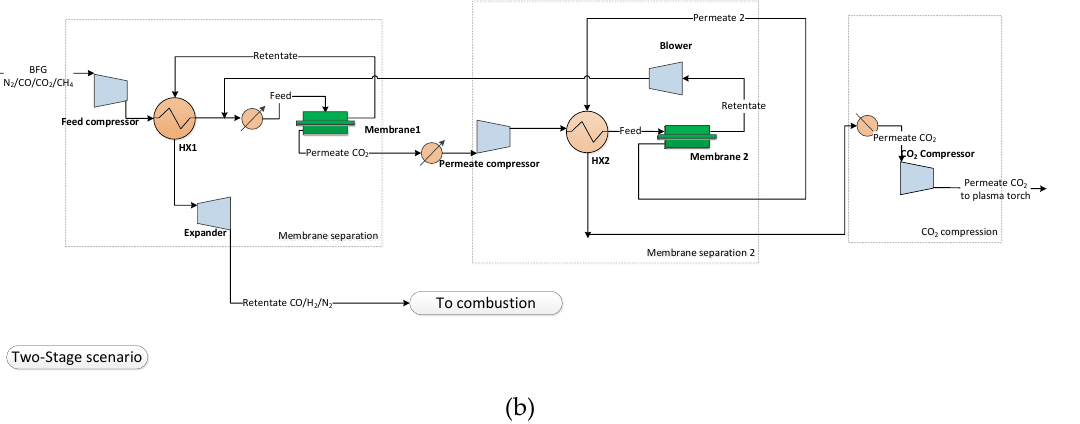
Figure 4. Process flow diagram of ( a ) one and ( b ) two stage separation scenarios. Standard models were used for the heating, cooling and compression required. As- sumptions used in the standard model are summarized in Table 3. Table 3. Assumptions used for modelling standard equipment [13,14].